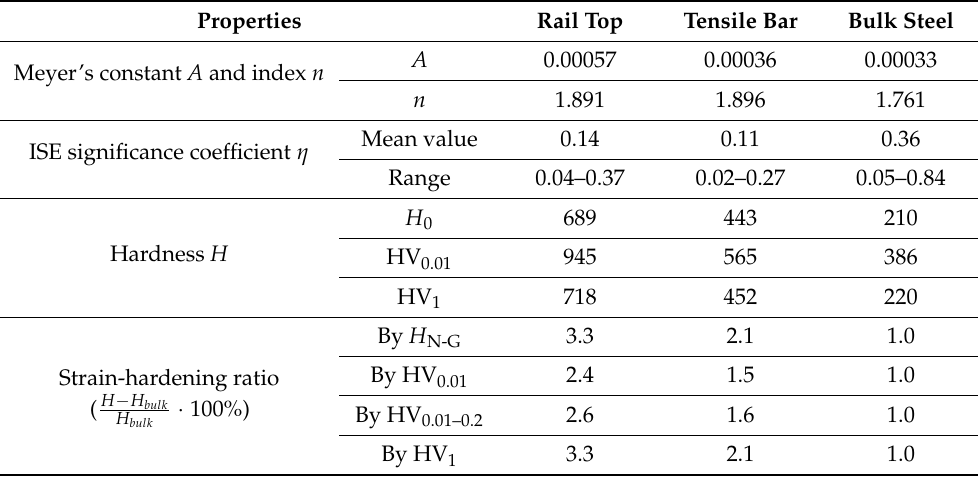
Table 6. Comparison of the ISE-related properties of strain-hardened Hadfield steel